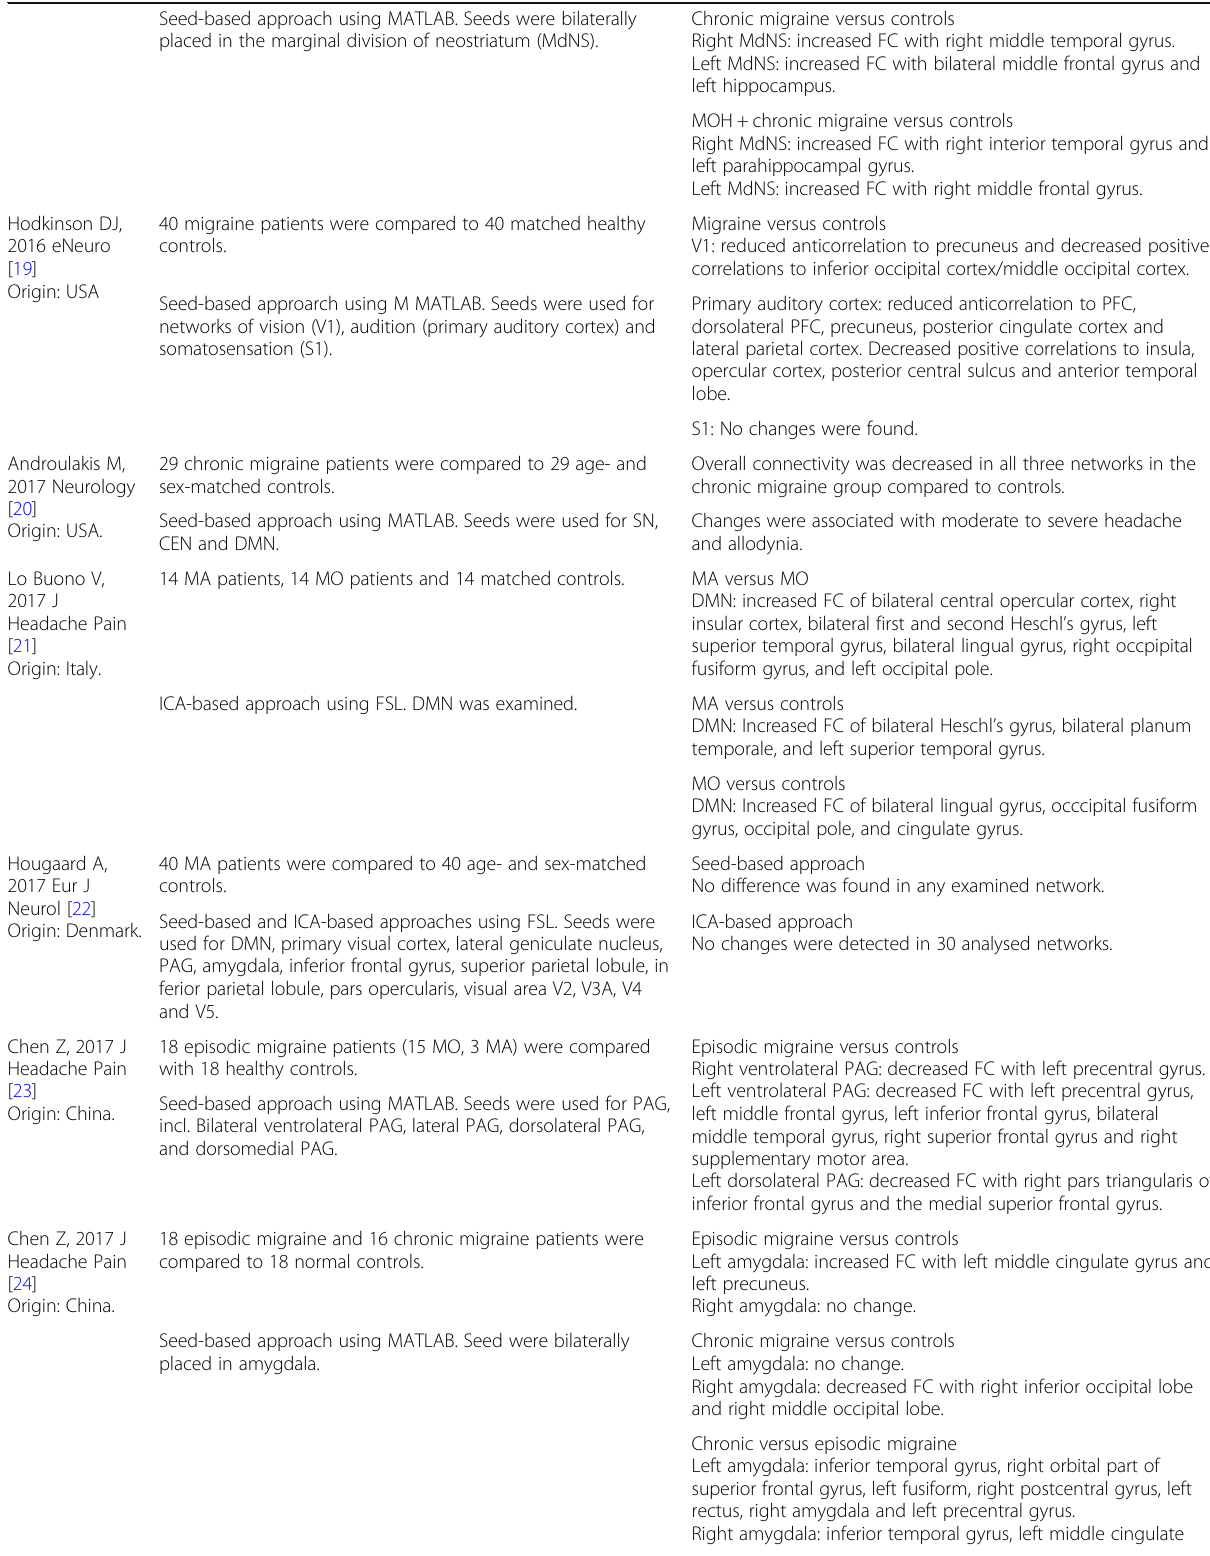
Table 1 Functional connectivity MRI during the interictal phase of migraine compared with non-migraine controls (Continued) Study Population and method Findings Seed-based approach using MATLAB. Seeds were bilaterally placed in the marginal division of neostriatum (MdNS).